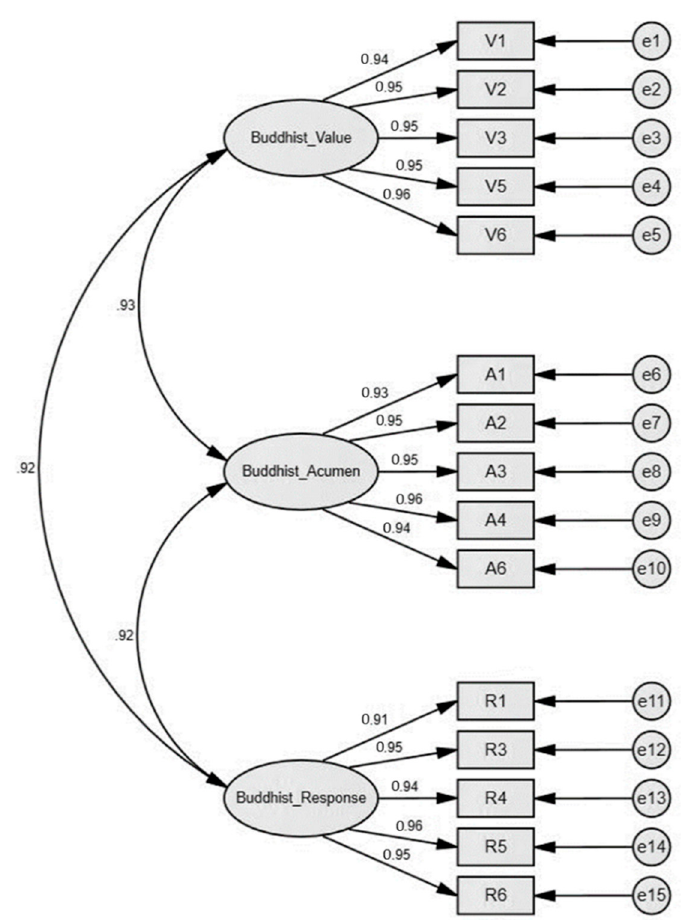
Figure 2. The path diagram of the Buddhist aesthetics scale.